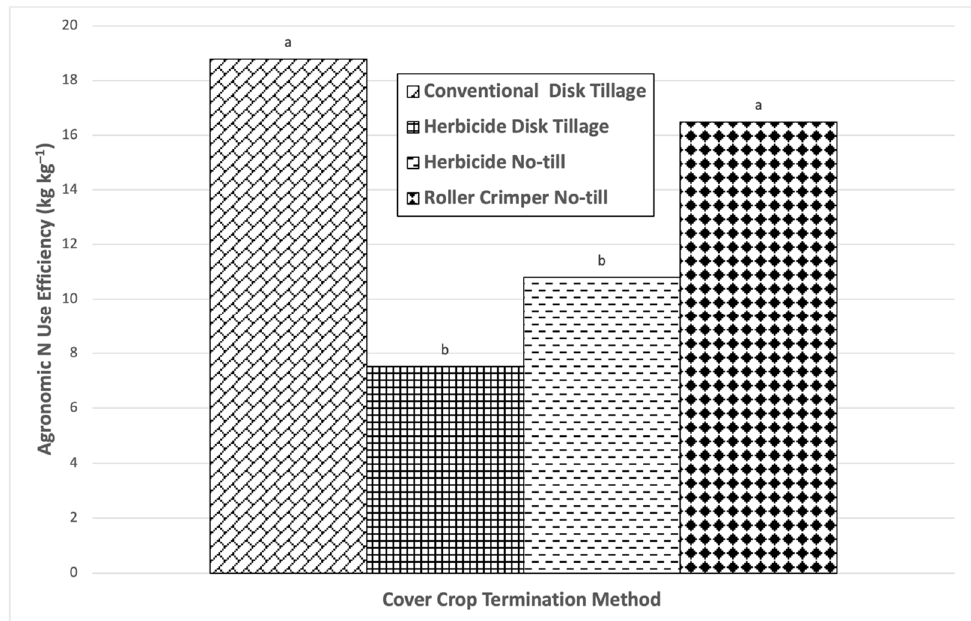
Figure 12. Mean N uptake in sweetcorn as a function of cover crop termination method in 2021. Columns marked with the same letter are not significantly different from each other according to Tukey’s HSD adjusted t tests at p ≤ 0.05.